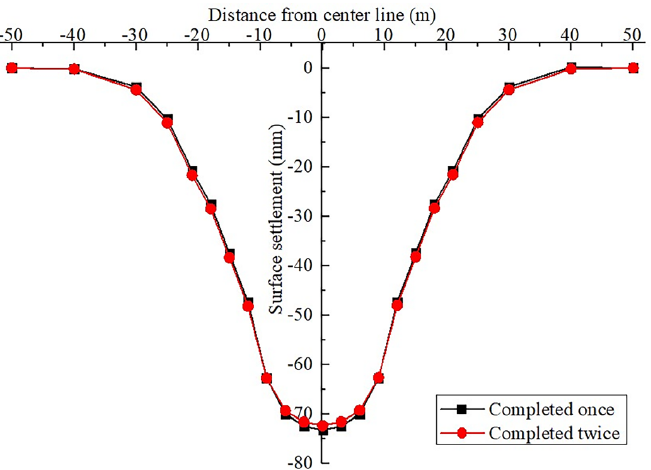
Figure 21. Surface subsidence curve after the completion of the two construction schemes.